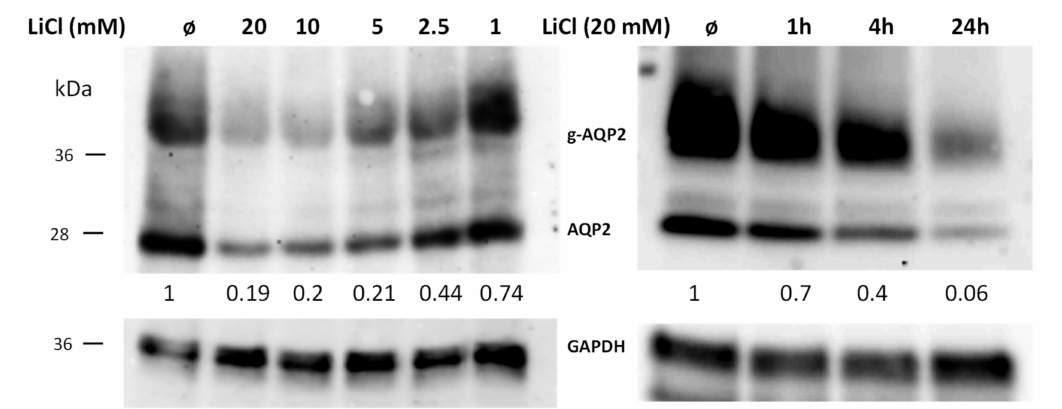
Figure 2. Downregulation of Aqp2 by LiCl is concentration and time dependent. IMCD cells were left untreated and treated for 24 h with di ff erent concentrations of LiCl (left panel, concentrations as indicated) or treated for di ff erent periods of time (right panel, time as indicated) with 20 mM of LiCl. The expression of Aqp2 was analyzed by Western blot. Afterwards, the antibodies were stripped, and the membrane was incubated with GAPDH. The numbers indicate the relative Aqp2 signal intensities compared to untreated cells (n = 1).